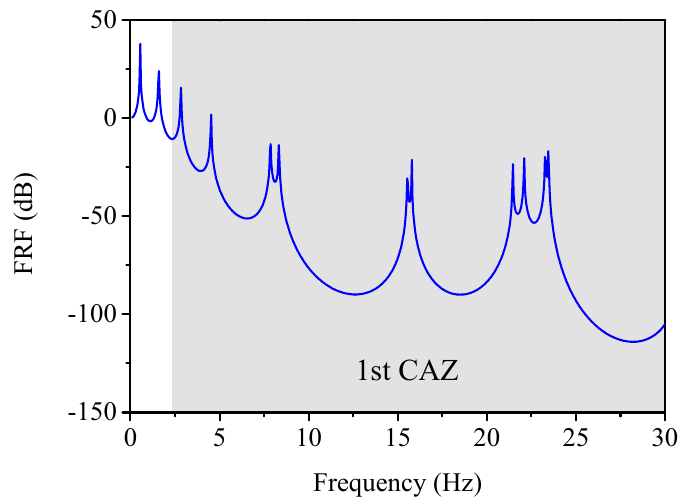
Figure 12. FRF of the designed combined layered periodic foundation (the geometric parameters of Ι –type unit cell are a = 0.5 m and f r = 22%, and those of ΙΙ –type unit cell are b = 1 m and f r = 30%).